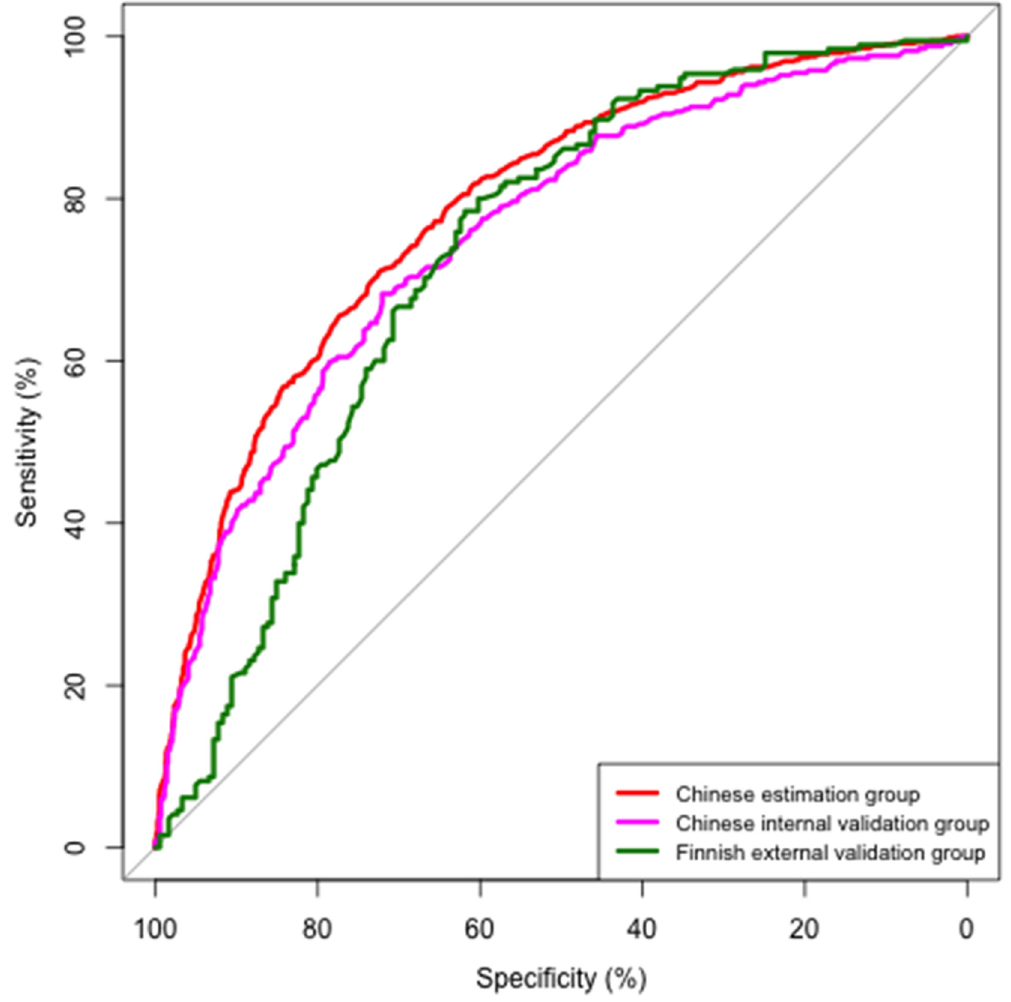
Fig 1. ROC-curves of the Chinese NAFLD score to predict NAFLD in the estimation group, the internal Chinese validation group and the Finnish external validation group. In the estimation group, AUROC = 0.79 (0.77, 0.81),cut-off = -0.79, Specificity = 0.72, Sensitivity = 0.71. In the internal Chinese validation group, AUROC = 0.76 (0.73, 0.78), cut-off = -0.79, Specificity = 0.71, Sensitivity = 0.69. In the Finnish external validation group, AUROC = 0.74 (0.69, 0.80), cut-off = 0.68, Specificity = 0.62, Sensitivity =